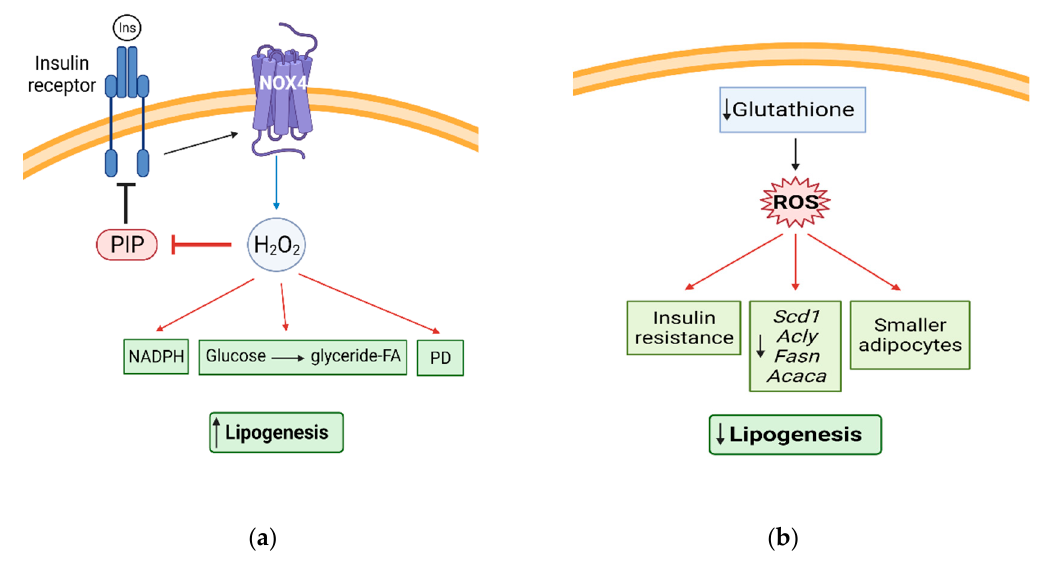
Figure 4. Redox signaling and lipogenesis. ( a ) H 2 O 2 acts as a secondary messenger of insulin in adipocytes by suppressing the oxidation of protein tyrosine phosphatases (PIP), thus facilitating insulin signaling. H 2 O 2 also increases lipogenesis by increasing NADPH and glucose incorporation into glyceride-FA, and stimulating pyruvate dehydrogenase (PD); ( b ) enhanced Fat ROS, through the depletion of glutathione in adipocytes, decreases insulin sensitivity, reduces lipogenic gene expression, and display smaller adipocytes.